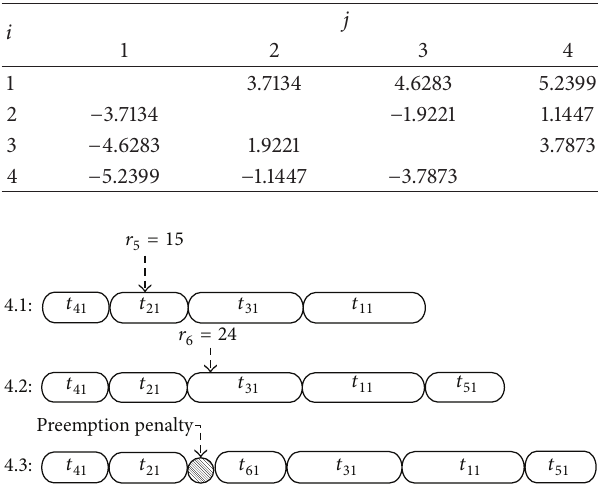
Figure 4: Scheduling a sample problem with proposed